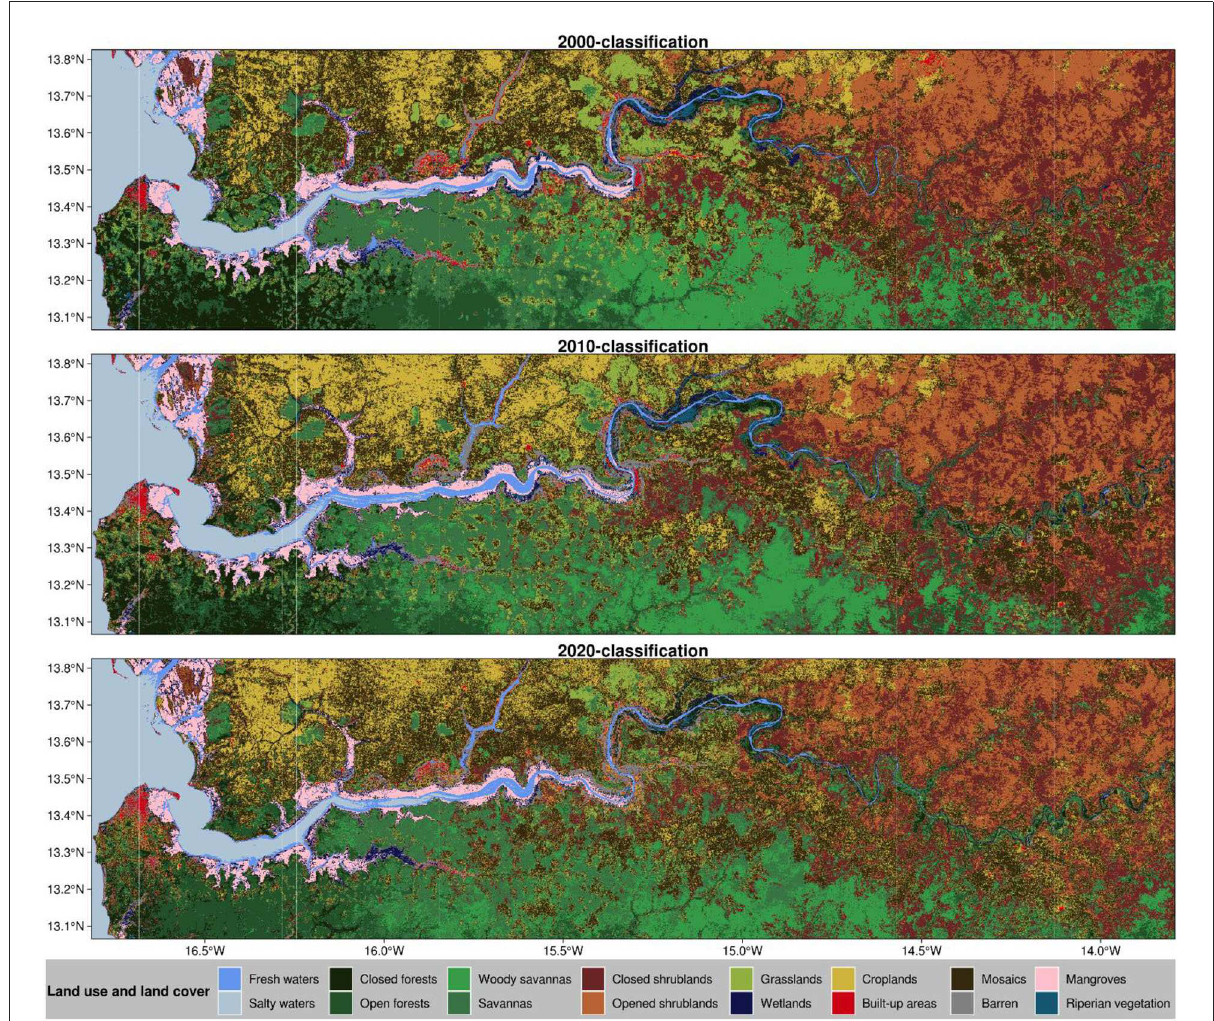
FIGURE4 Land use and land cover classifications of The Gambia based on harmonic modeling of image time series acquired over the periods 2000–2002 (2000-classification), 2010–2012 (2010-classification), and 2018–2020 (2020-classification). These maps were derived by filling data gaps in Landsat monthly median composites using the equivalent MODIS data where these MODIS data are